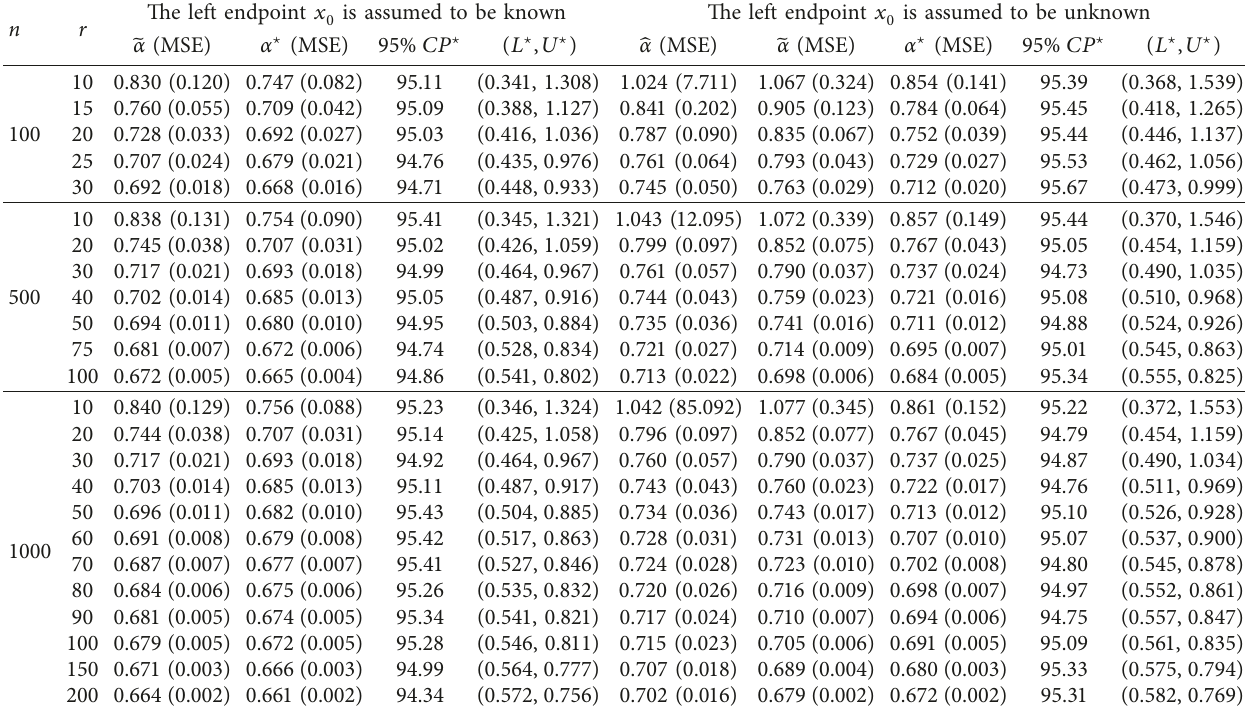
, ... , X r : n for different values 1 : n ) . 2/3 is assumed to be 0